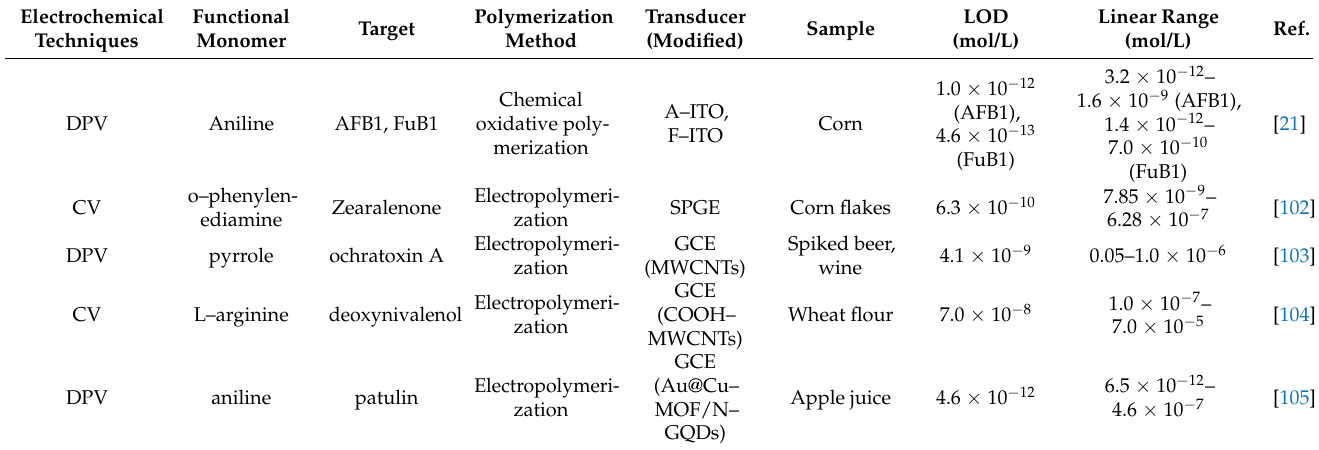
Table 4. Detection of food mycotoxins by different MIP electrochemical biomimetic